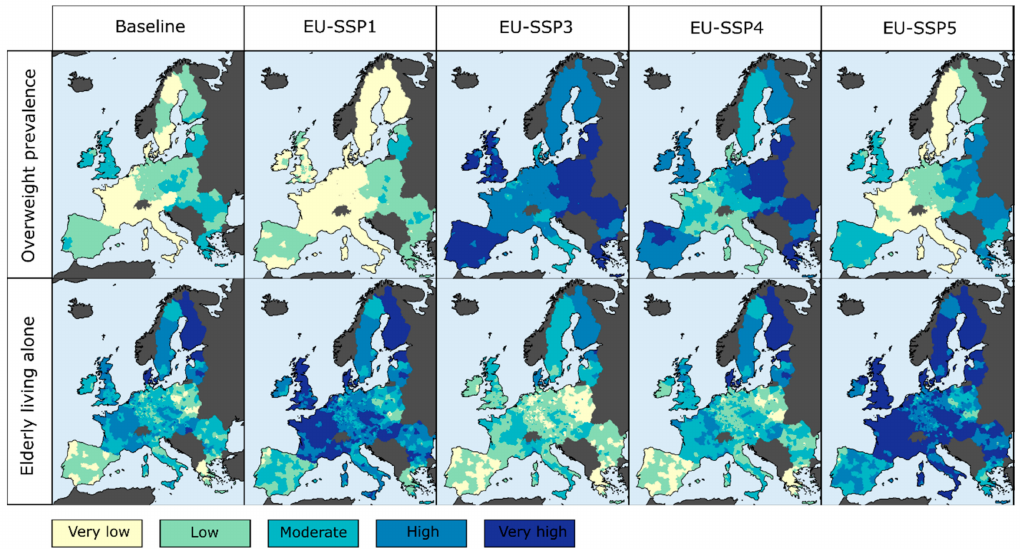
Figure 4. Projections of the prevalence of overweight and of the proportion of elderly living alone, under the four European SSPs (2050) and for current conditions (2015), aggregated at the NUTS-3 level, for the 28 member countries of the European